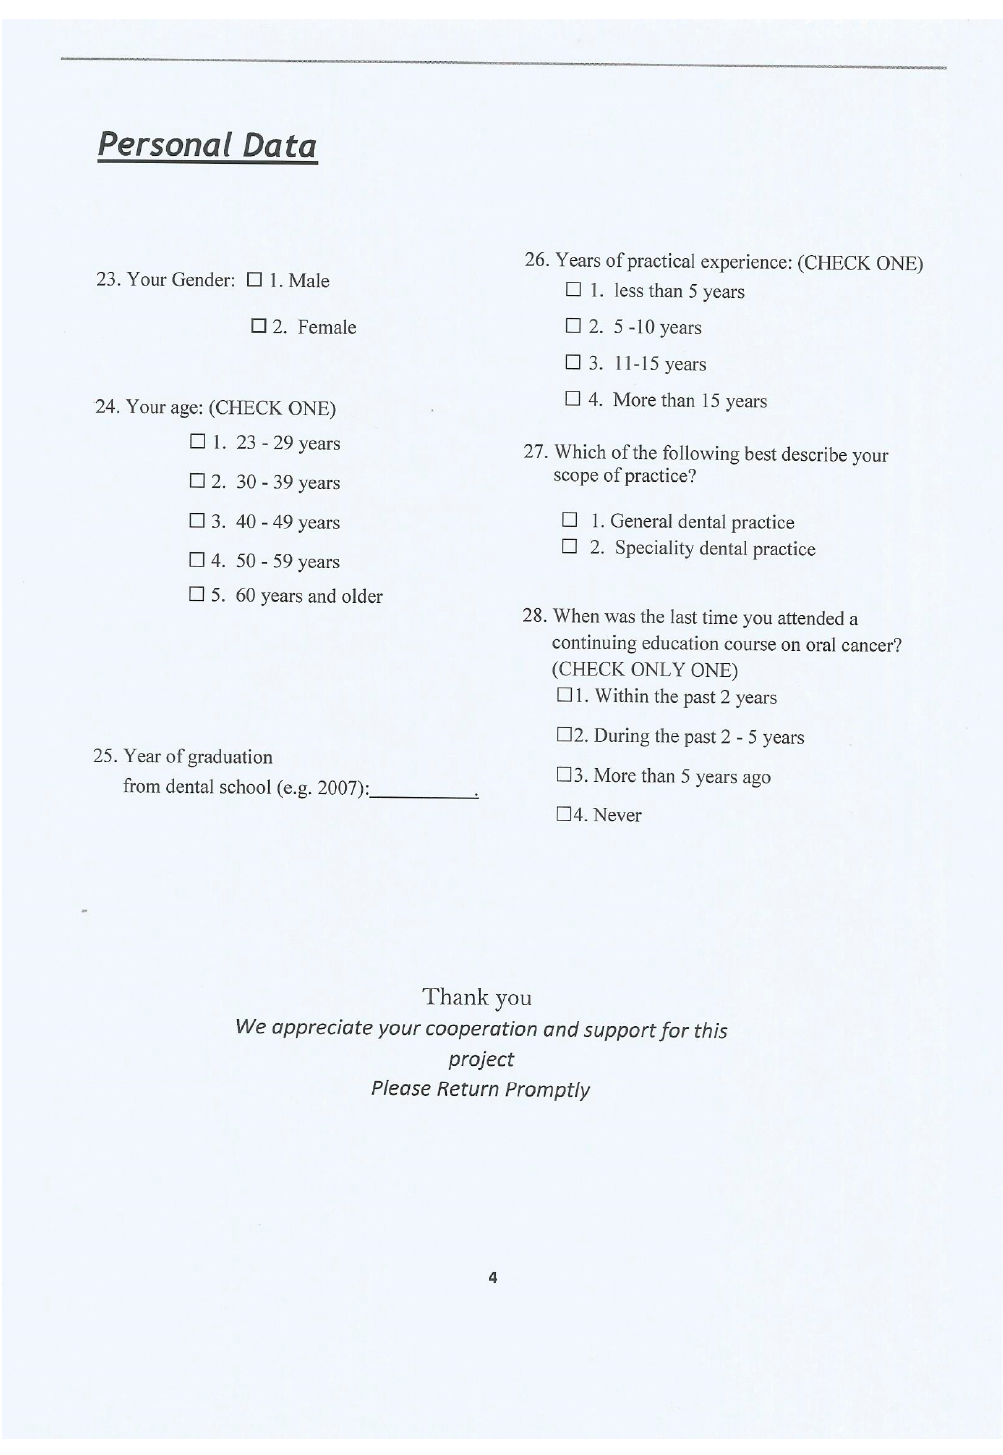
Figure A1. The Study Questionnaire.